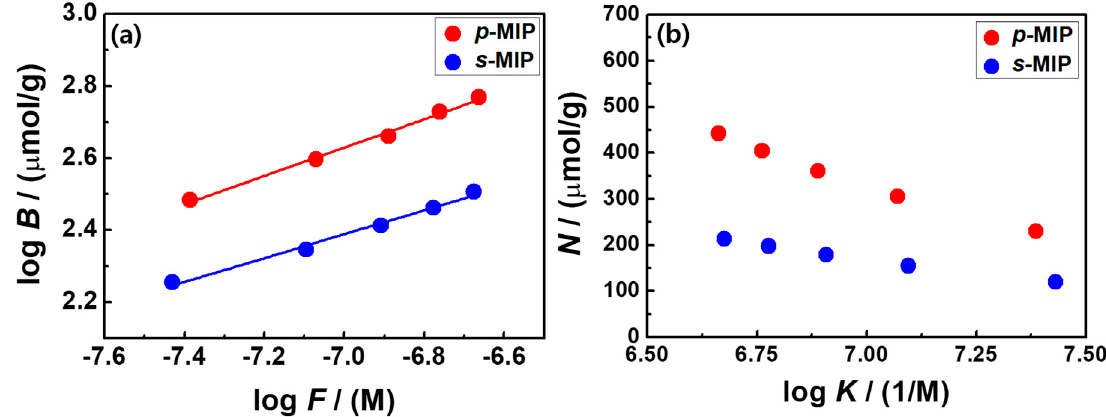
Figure 3. ( a ) Plot of log B versus log F , where B is equal to the Q e values ( µ mol / g), and F is the concentration of the free analyte in solution after 1-h BPA adsorption; ( b ) a ffi nity distributions of p -MIP and s -MIP films derived from the Freundlich model plotted against N formats as a function of log K , where K is the a ffi nity constant in 1 / M and N ( K ) ( µ mol / g) is the number of binding a ffi nities for a given affinity.